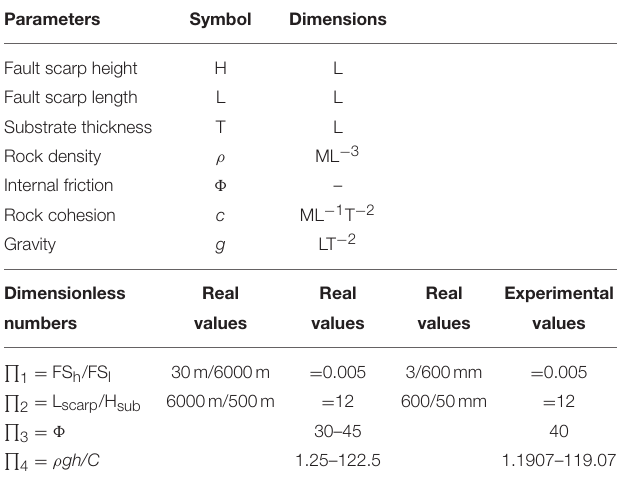
TABLE 1 | List of parameters and dimensionless numbers used in this work. Parameters Symbol